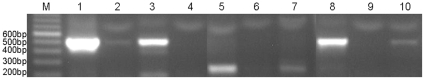
Transcription of ncrA, ncrB, and ncrC is induced by 4 mM NiCl2.Lanes 1-4: PCR amplification (502 bp) of ncrA from genomic DNA using primers RT-nrcAF and RT-nrcAR (lane 1); cDNA from non-induced cultures (lane 2); cDNA from nickel-induced cultures (lane 3); and RNA from nickel-induced cultures (lane 4). Lanes 5-7: PCR amplification (270 bp) of ncrB from genomic DNA with primers RT-nrcBF and RT-nrcBR (lane 5); cDNA from non-induced cultures (lane 6); and cDNA from nickel-induced cultures (lane 7). Lanes 8–10: PCR amplification (523 bp) of ncrC from genomic DNA with primers RT-nrcCF and RT-nrcCR (lane 8); cDNA from non-induced cultures (lane 9); and cDNA from nickel-induced cultures (lane 10).